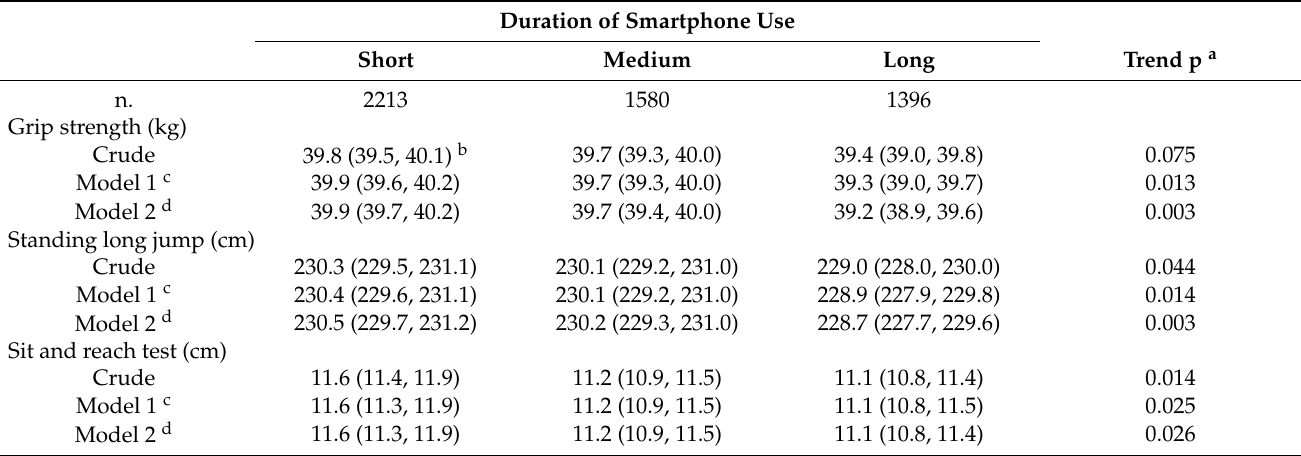
Table 3. Adjusted relationship between smartphone-use duration and physical fitness in male participants. Duration of Smartphone Use Short Medium Long